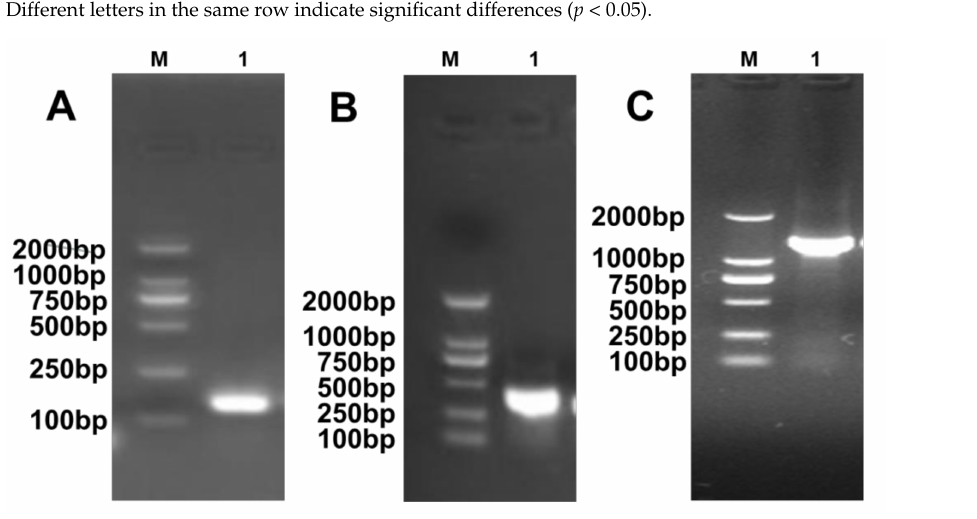
Figure 2. RACE analysis of KRT17 sequence ( A ) 5 (cid:48) UTR; ( B ) 3 (cid:48) UTR; and ( C ) CDS. M refers to the DL2000 Marker.